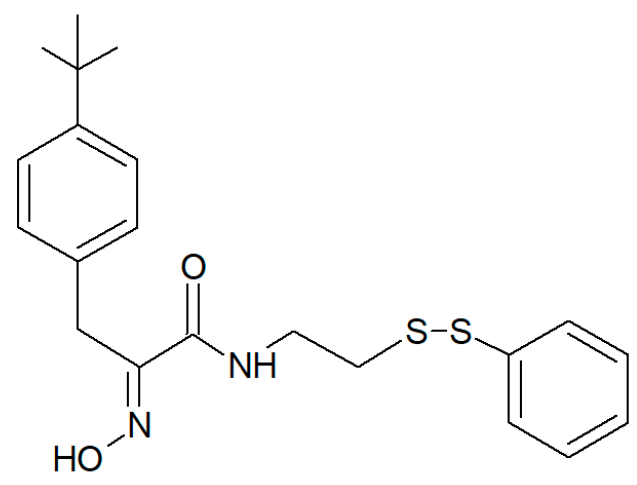
Figure 7. Structure of psammaplin A-3091 [56].